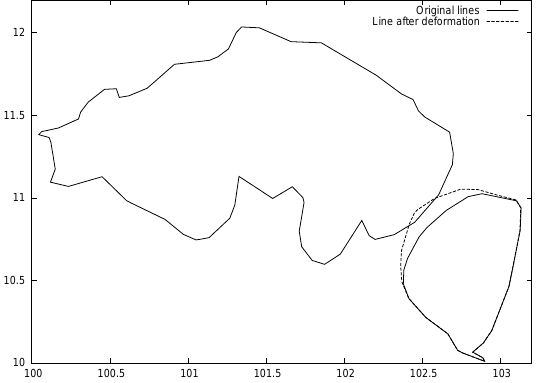
Figure 3: Feature deformation for aggregation.